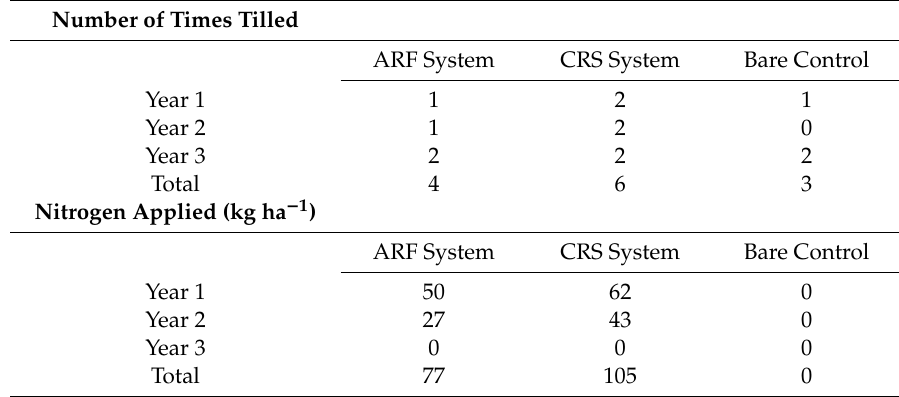
Table 1. Disturbance (number of times tilled) and enrichment (nitrogen applied) in each rotation system. Number of Times